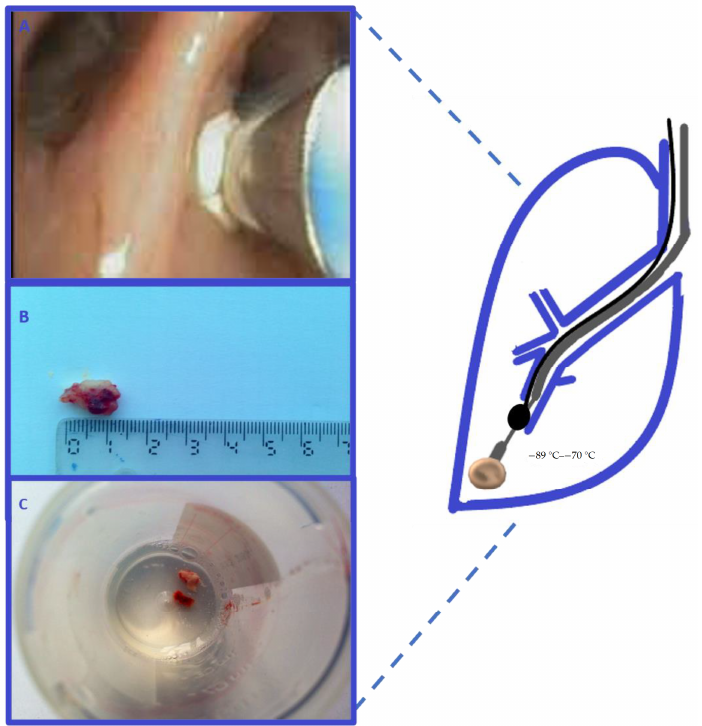
Figure 2. Transbronchial cryobiopsy of a peripheral lung tumor. The cryoprobe (grey) is introduced through the fiberoptic bronchoscope 6.2 mm working channel. The probe is cooled for 5–6 s (image A ). A Fogarty balloon (black) is placed in the proximal lobar bronchus from the lesion and is inflated after the biopsy. The cryobiopsy sample has a larger size of >10 mm (images B , C ).